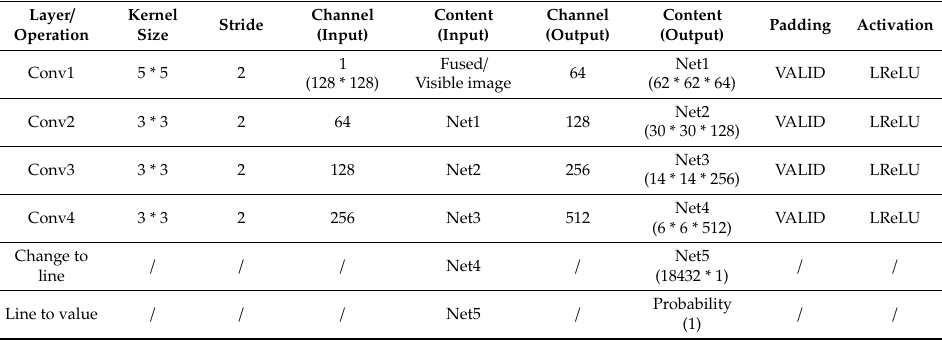
Table 2. The architecture of the